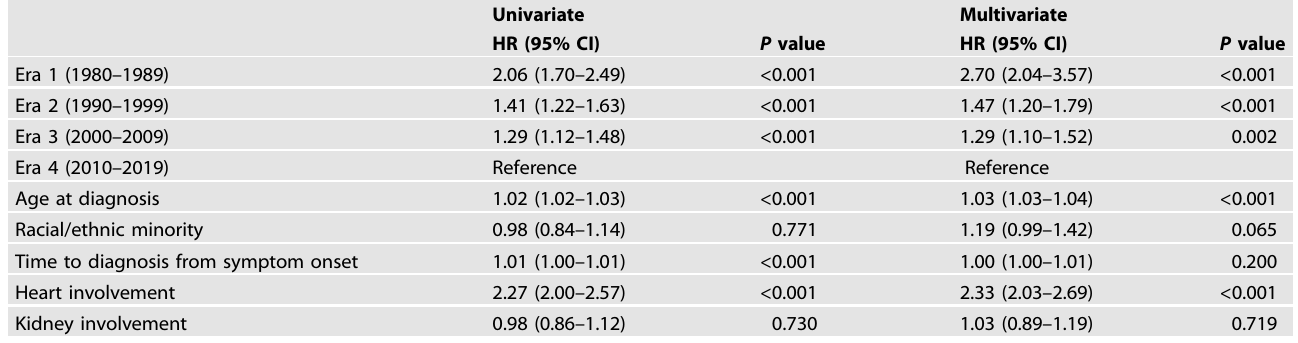
Table 3. Univariate and multivariate analyses of mortality